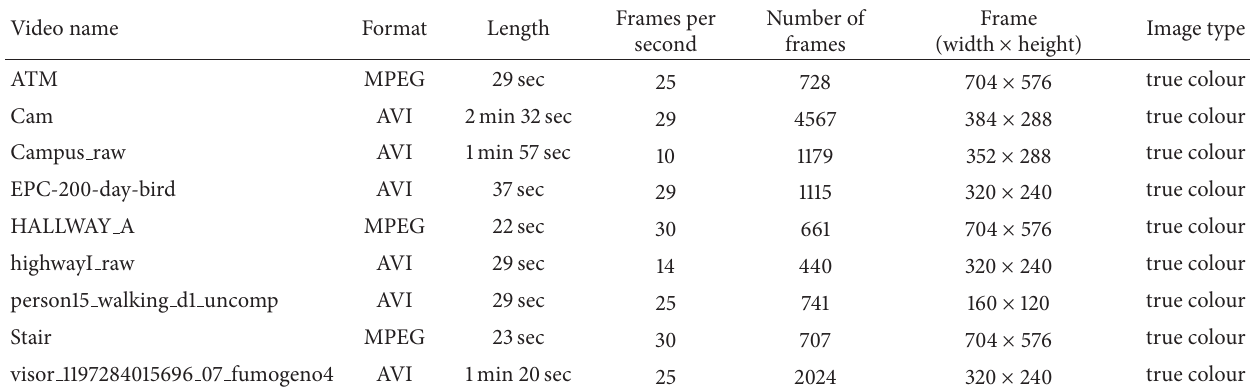
Table 1: Detail information of test